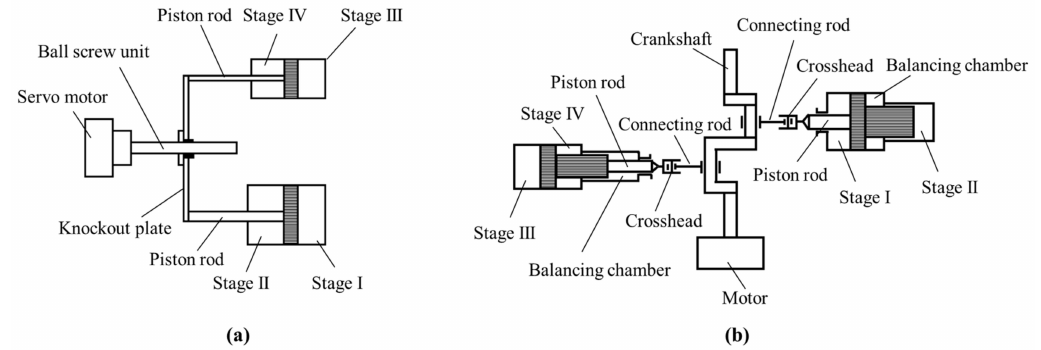
Figure 2. Structure comparison between ( a ) the proposed compressor and ( b ) the conventional